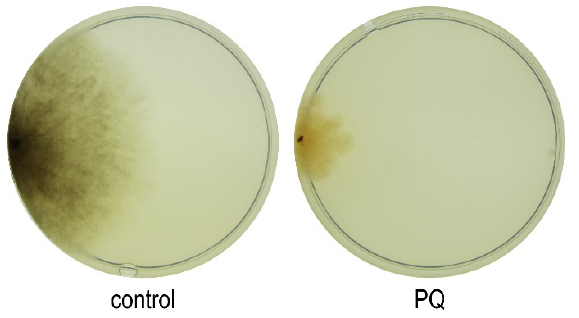
FIGURE 3: Effect of PQ-stress on the phenotype of P. anserina . Cultures of the wild type grown for 8 days on PQ-free CM medium or on CM medium supplemented with 200 µM